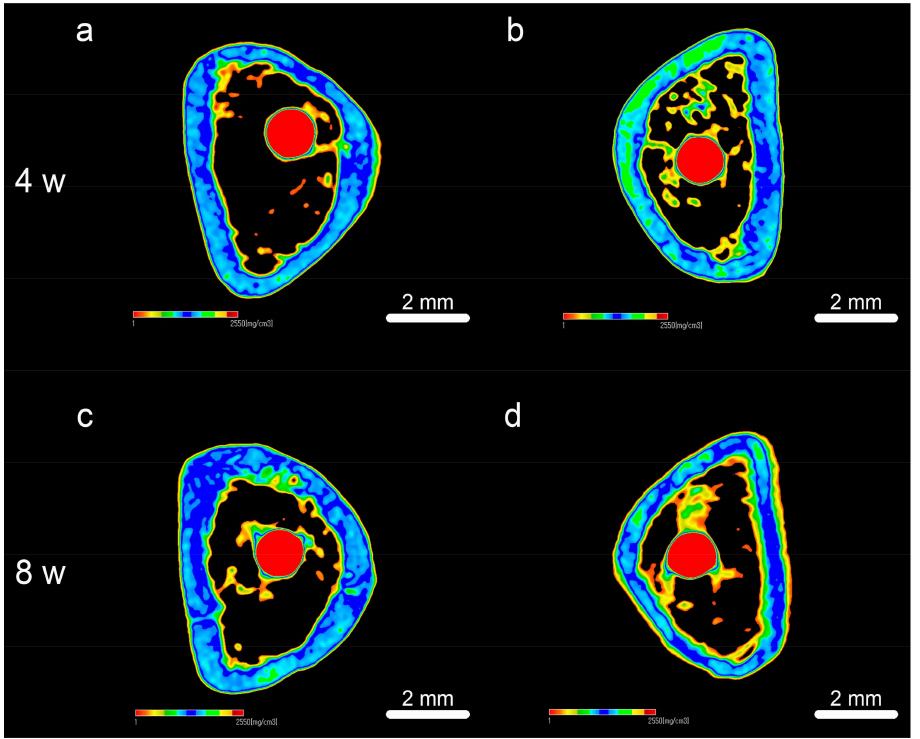
Figure 8. Transverse reconstructed microcomputed tomographs of ( a , c ) Ti and ( b , d ) FHA-coated implants after ( a , b ) 4 weeks and ( c , d ) 8 weeks.